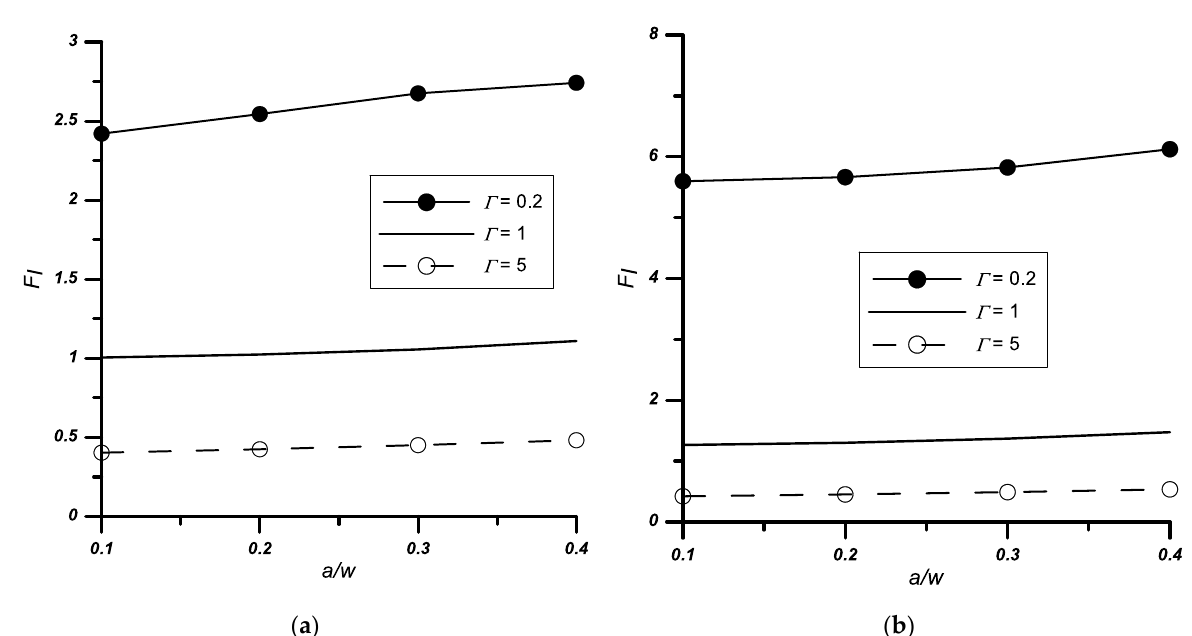
Figure 9. Variation of the normalised stress intensity factors F I with the relative stiffness Γ and notch height a / w , ( a ) notched bi-material with apex angle 2 ψ = 30°, ( b ) notched bi-material with apex angle 2 ψ = 90°.